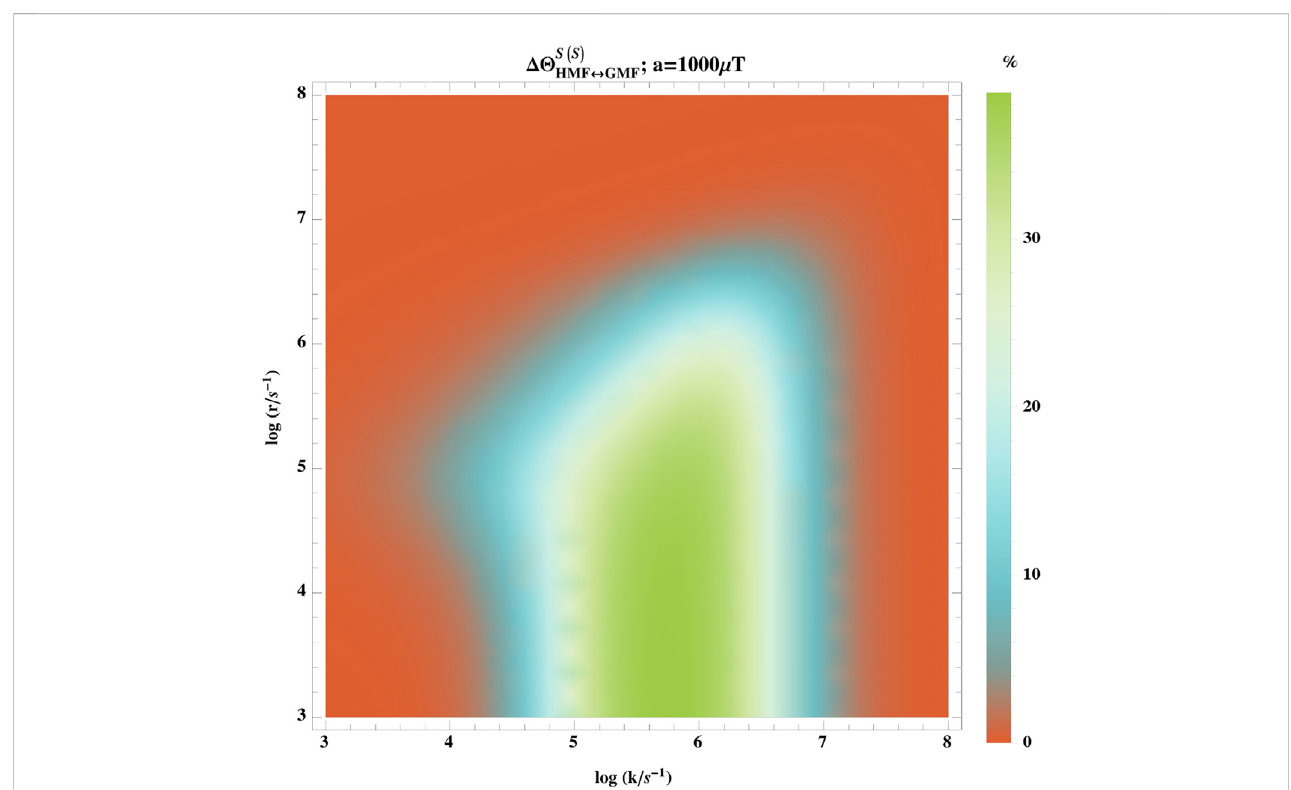
FIGURE 4 Dependence of ΔΘ S ( S ) HMF ↔ GMF on k and r . The hypomagnetic fi eld effect isbased on thesinglet yield ratio of 1 μ T(HMF) over 50 μ T (GMF) with singlet initial states. In this model, one of the radicals has no hyper fi ne interaction, and the other one is coupled to one nucleus with an isotropic hyper fi ne coupling constant of a = 1,000 μ T. The hypomagnetic fi eld effects are signi fi cant when r < 10 6 s − 1 , k ∈ [10 4.5 , 10 6.5 ] s − 1 , and k < r